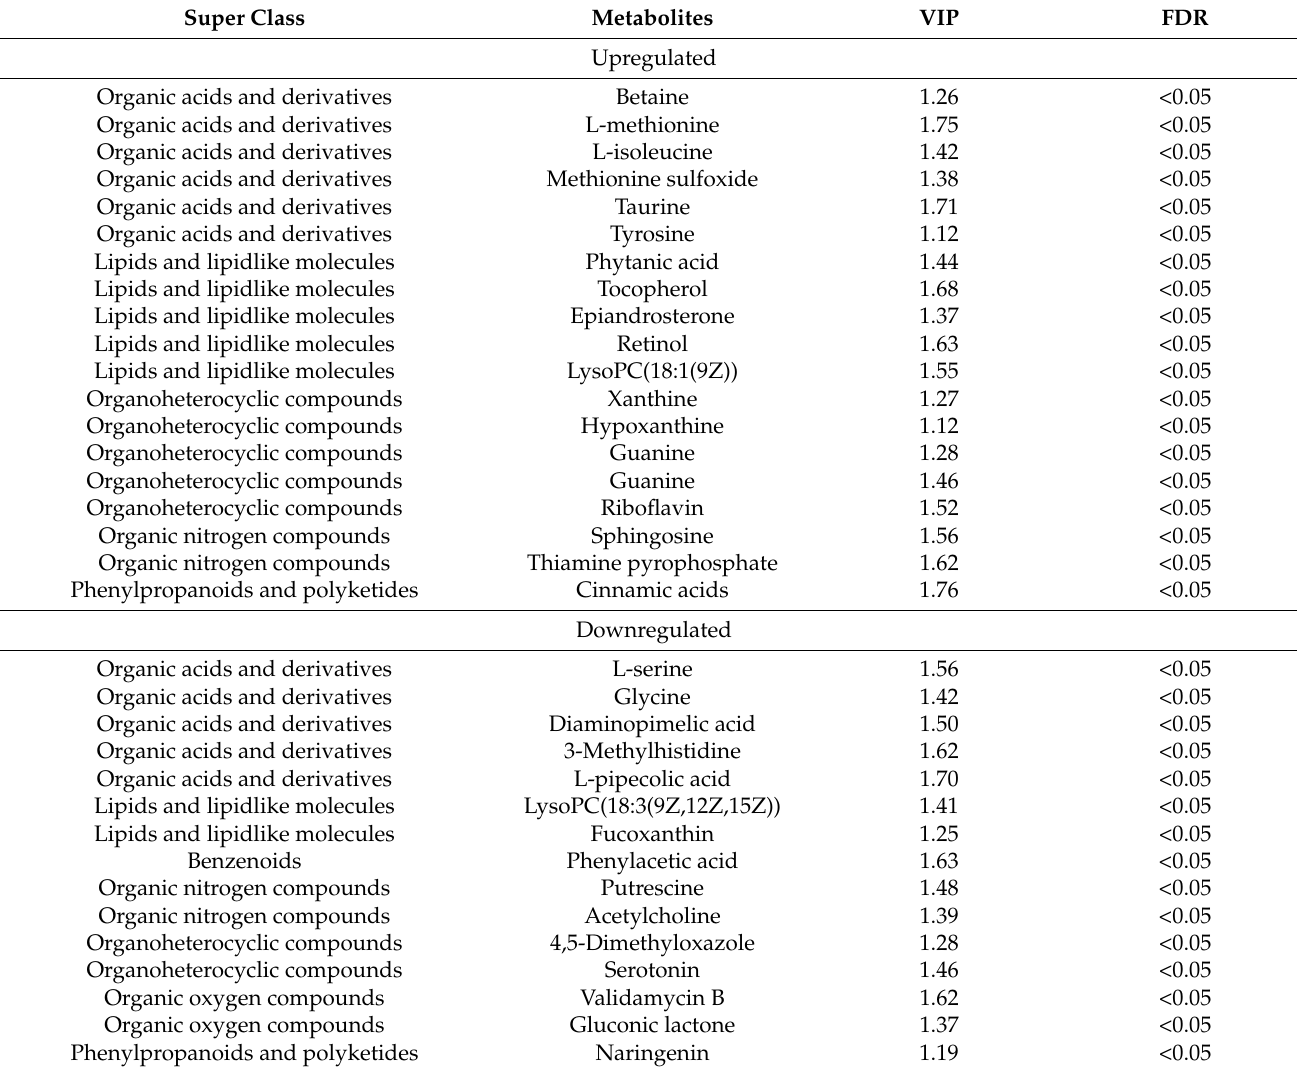
Table 6. Differential plasma metabolites in steers supplemented with 0 and 24 g HMBi d − 1 using a VIP threshold of